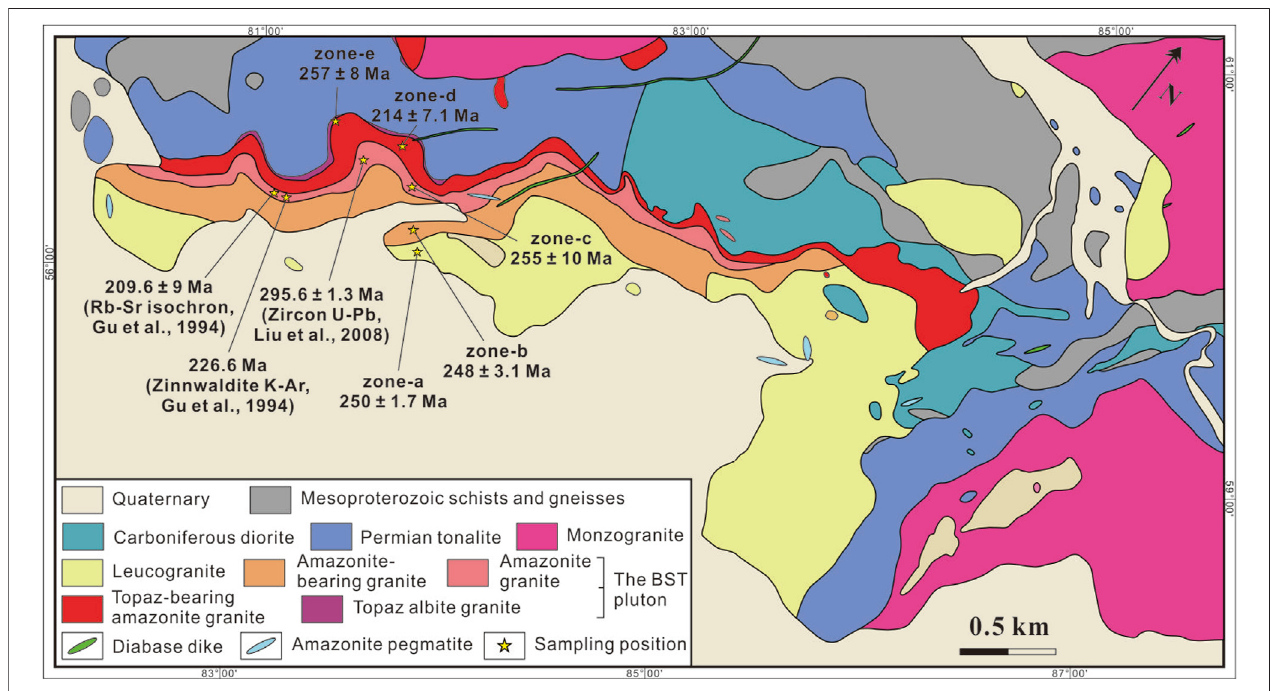
FIGURE 2 | Simpli fi ed geological map of the Baishitouquan (BST) in the Central Tianshan Block.